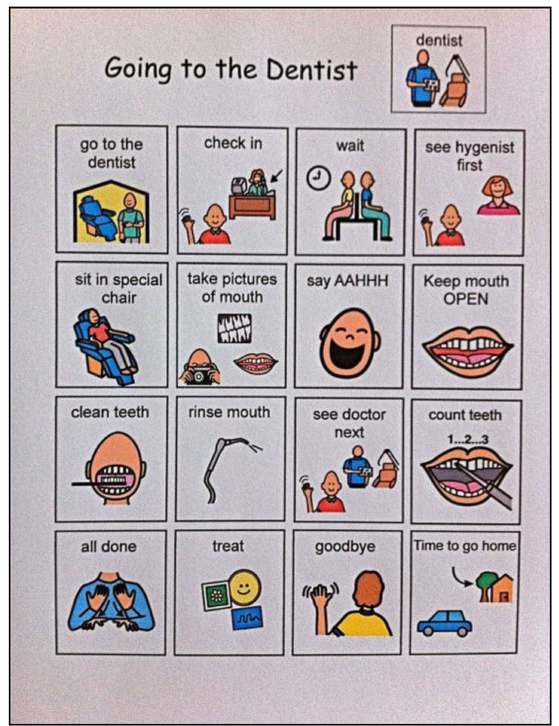
Figure 3. The regular dental visual aids: going to the